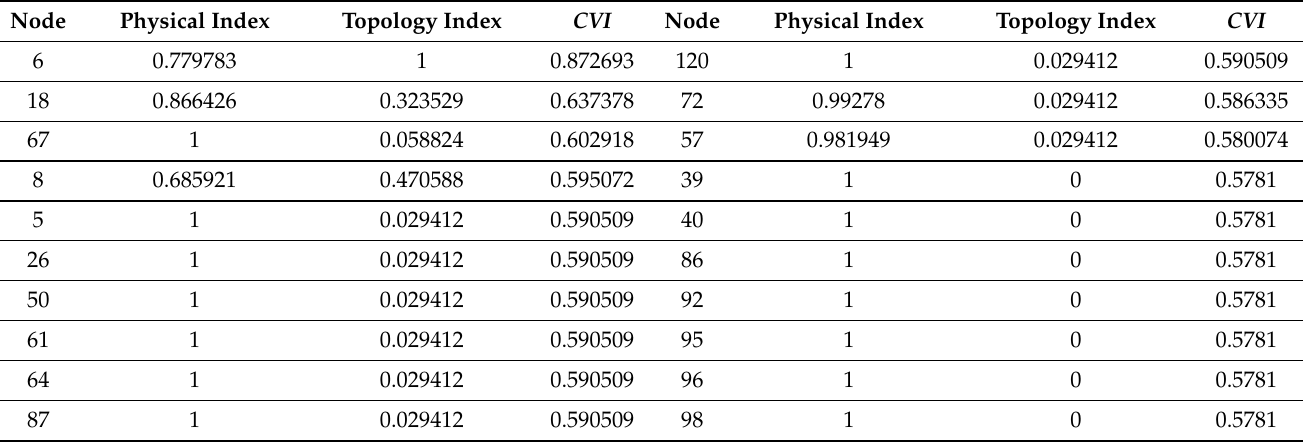
Table 3. Vulnerability indexes of Top 20